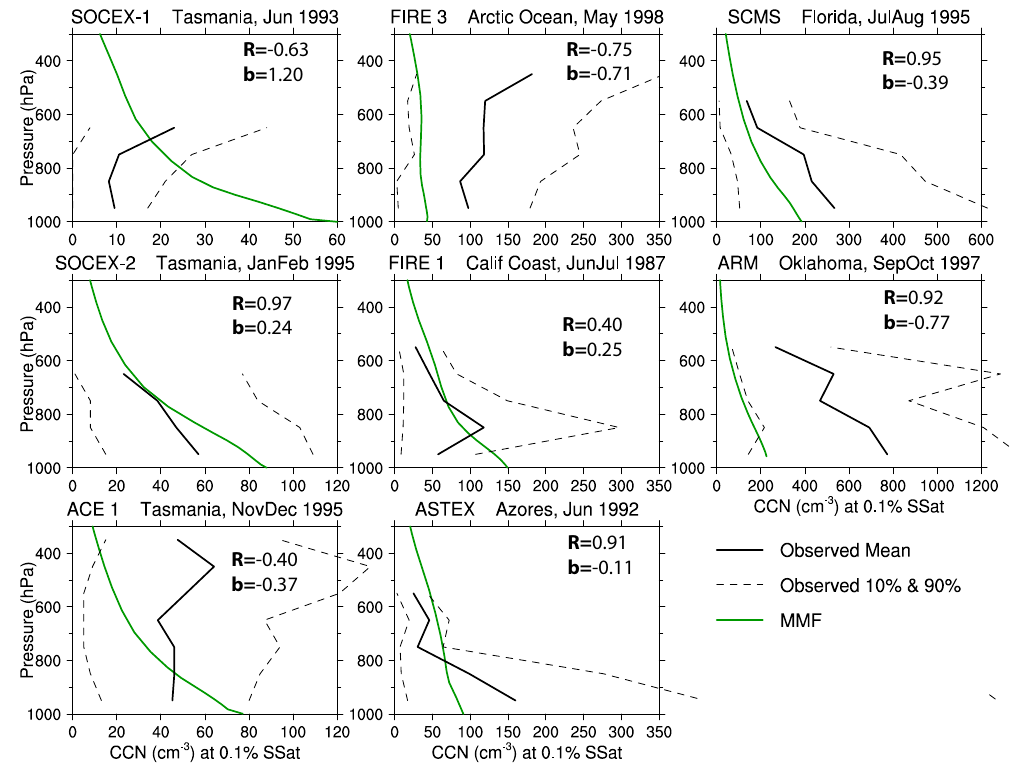
Fig. 21. Simulated vertical profiles of CCN concentrations at 0.1% supersaturation are compared with observations during each of eight field experiments (SOCEX-1, Tasmania, June, 1993; FIRE 3, Arctic Ocean, May, 1998; SCMS, Florida, July/August, 1995; SOCEX-2, Tasmania, January/February, 1995; FIRE-1, California Coast, June/July, 1987; ARM, Oklahoma, September/October, 1997; ACE1, Tasma- nian, November/December, 1995; ASTEX, Azores, June, 1992) (ee Table 1 in Ghan et al., 2001 for more details about each experiment). Model results are from monthly data, and shown in green line. Mean (solid black), 10 percentile and 90 percentile (dash lines) are shown for observations. Normalized model mean bias (b) and the correlation coefficient between the model and observations (R) are shown in each panel. Values of b and R are calculated using observed values provided at discrete altitudes and model values interpolated from model grid to those altitudes.